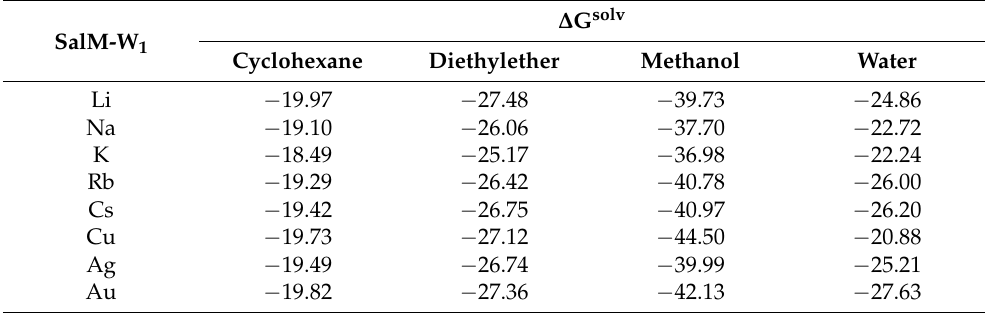
∆ G solv = E solvent − E gas-phase. Table 6. Gibbs free energies of solvation evaluated from PCM calculations for salinomycin complexes containing two water molecules in solvents with different dielectric constants (in kcal/mol). ∆ G solv SalM-W 2 Cyclohexane